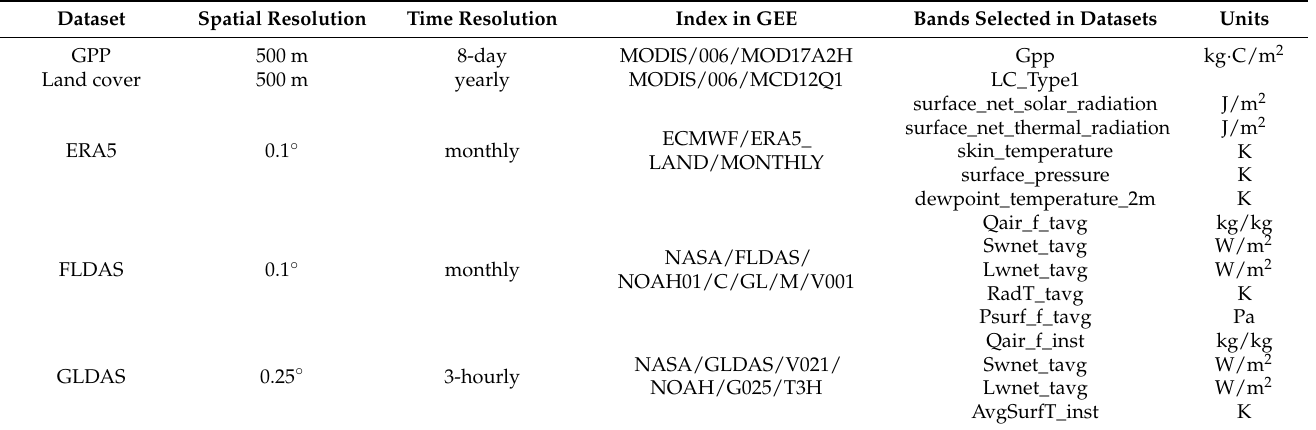
Table 1. Details of GEE